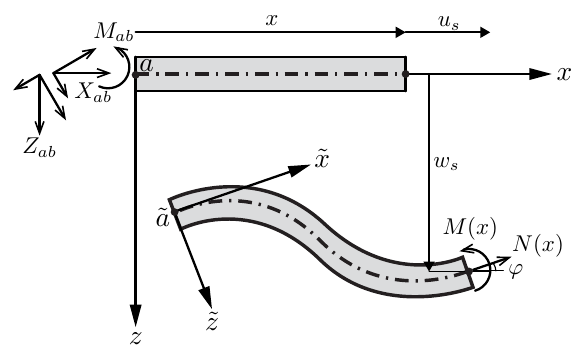
Figure 2. Schematic representation of beam internal forces at a general cross section x and left-end forces and